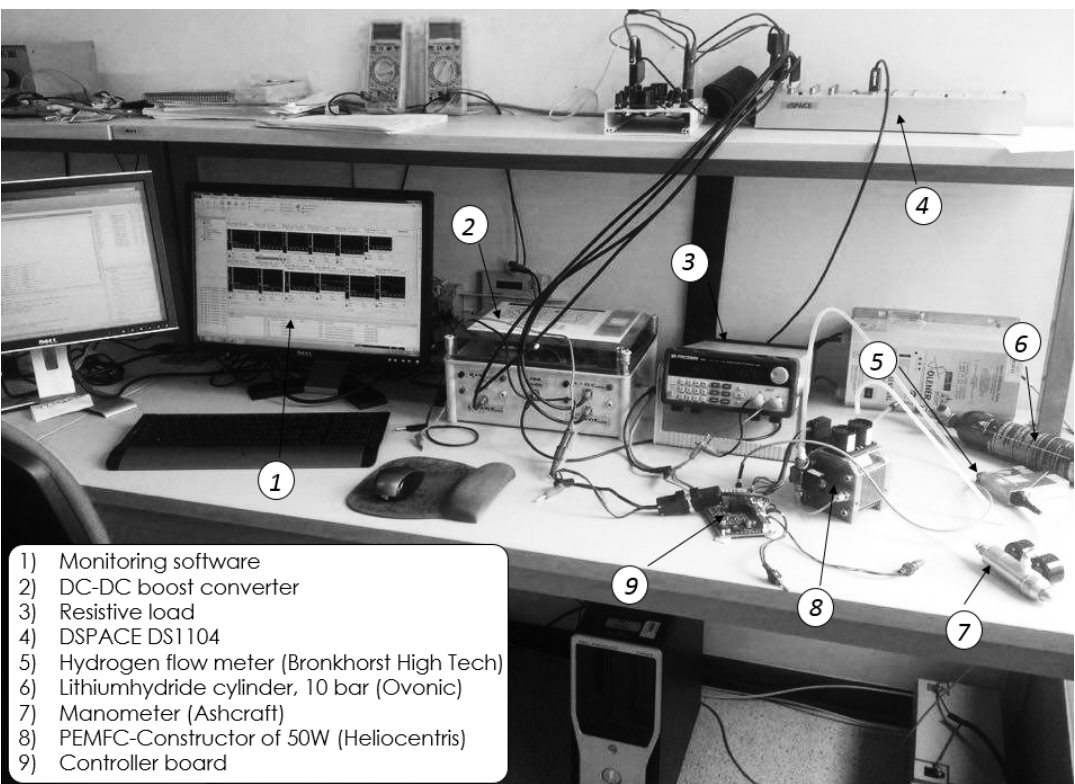
Figure 7. Experimental